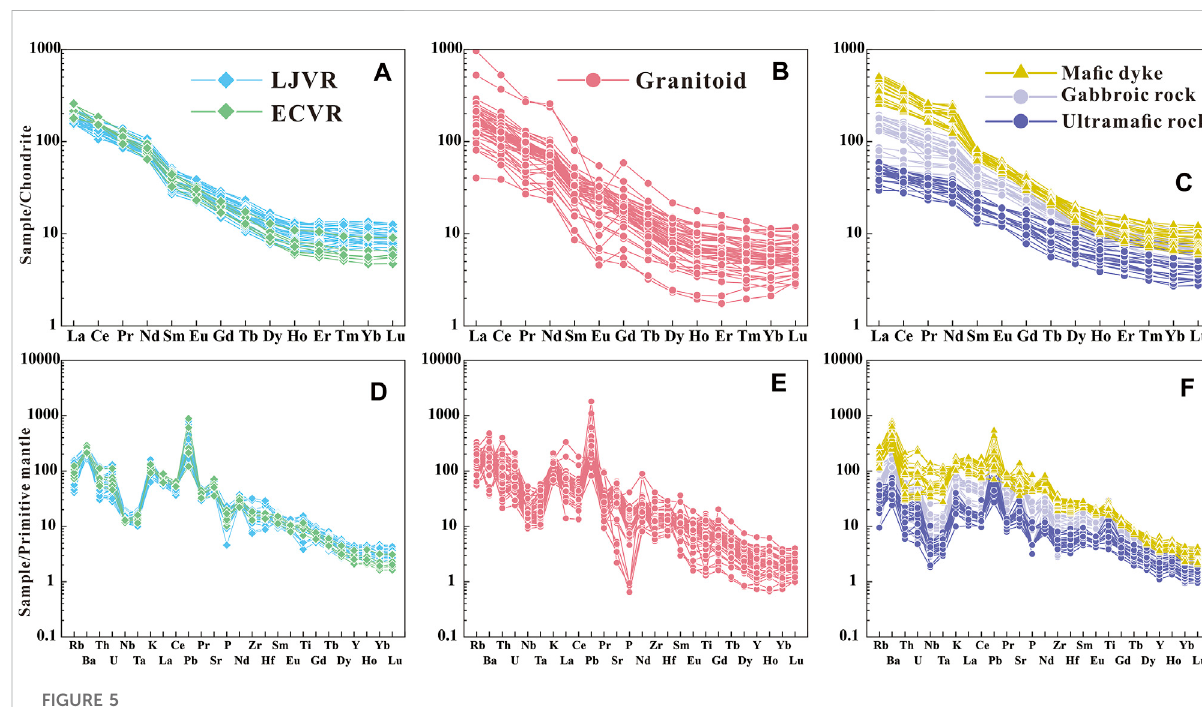
FIGURE 5 (A – C) Chondrite-normalized REE patterns for the Laiyuan magmatic rocks. (D – F) Primitive mantle-normalized trace element diagrams for of the Laiyuan magmatic rocks. Normalized values: chondrite (Mcdonough and Sun, 1995), primitive mantle (Sun and Mcdonough, 1989). Data source are same as in Figure